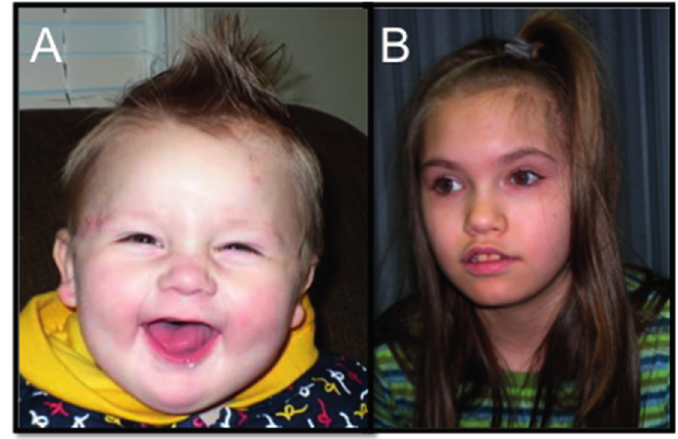
Figure 1. Craniofacial features of 2q23.1 deletion syndrome. Children with 2q23.1 deletion syndrome exhibit broad forehead, open mouth, and tented, thin upper lip.